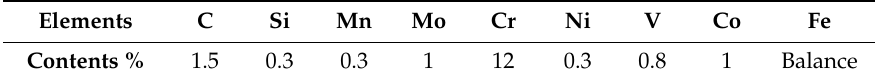
Table 1. Elemental composition of D2 steel [33].